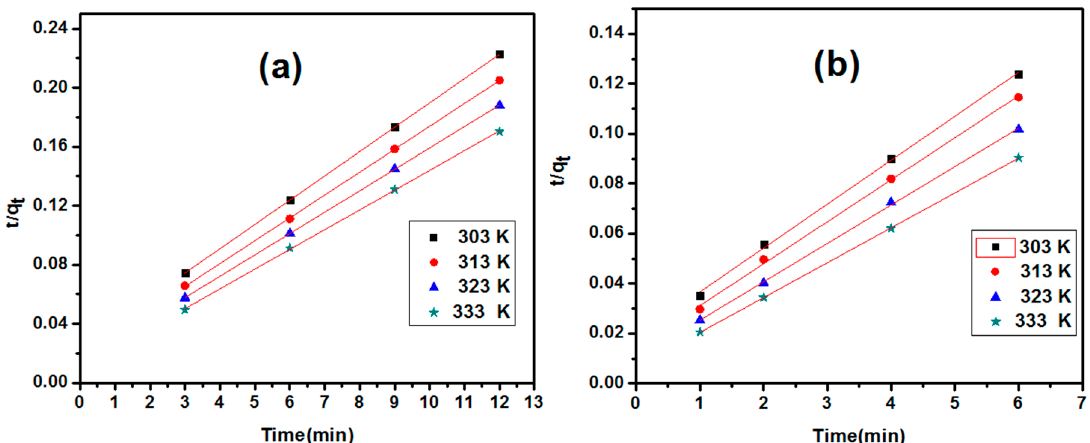
Table 3. Adsorption kinetics parameters of the pseudo-first-order model and pseudo-second-order model for U(VI) and Th(IV) sorption onto HQ-bentonite at different temperatures.